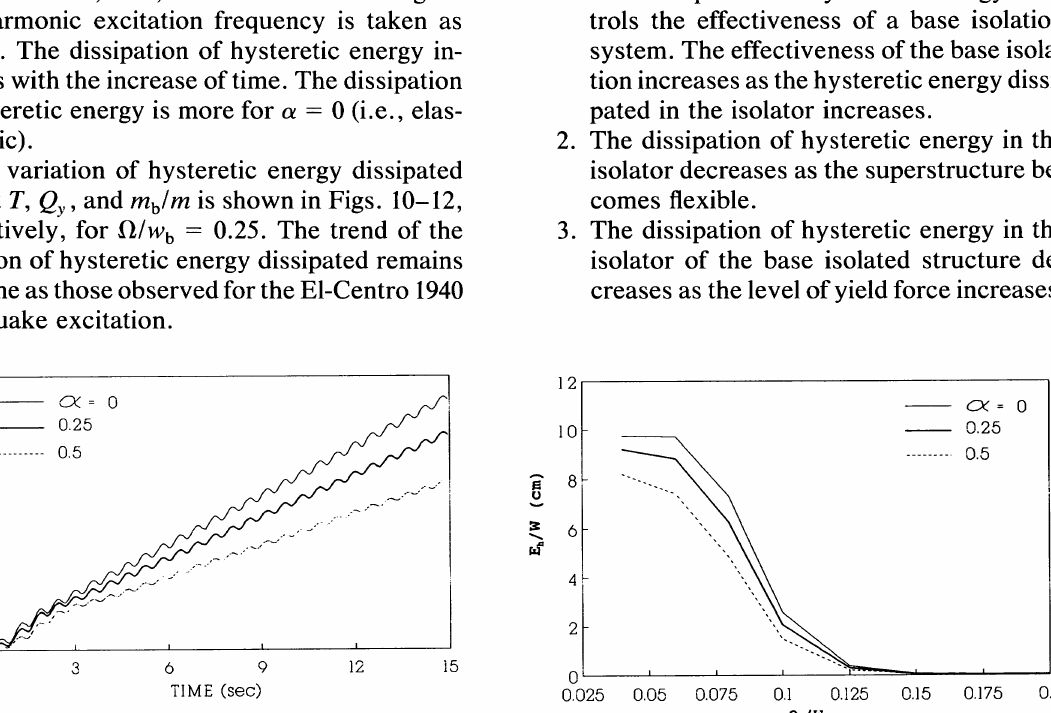
FIGURE 9 Time variation hysteretic energy dissi pated for harmonic excitation; T = 1 s, mb1m = 1.5, and QylW = 0.08.